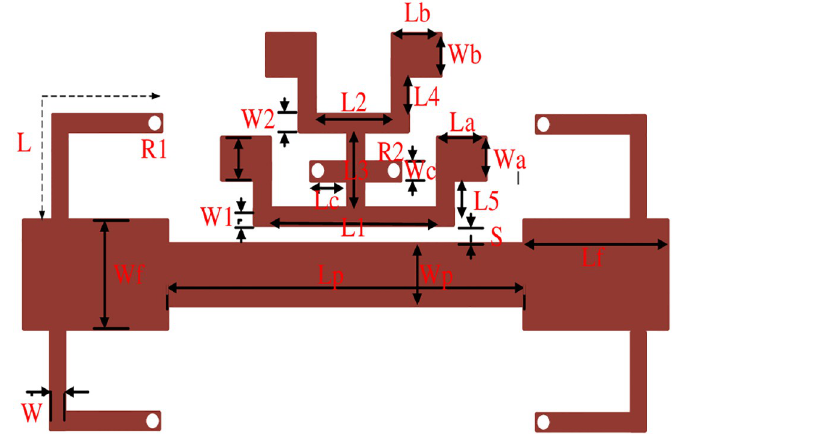
Fig 3. Complete layout of the UWB triple notch filter.